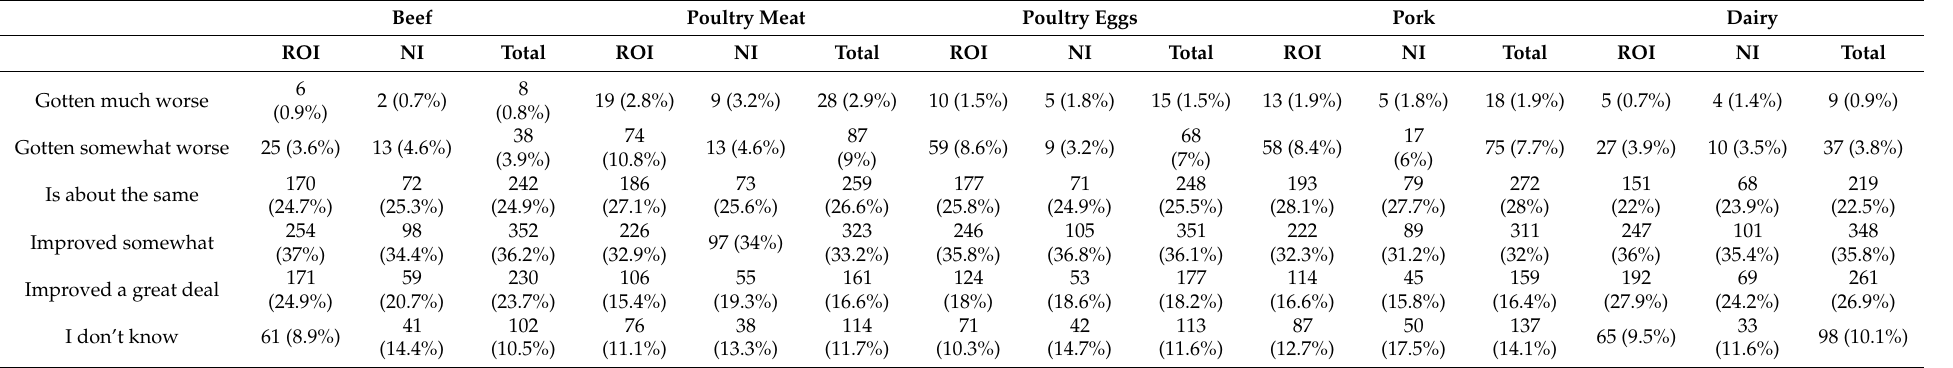
Table 3. Survey-based consumer perceptions ( n = 972) in the Republic of Ireland (ROI) and Northern Ireland (NI) of change in farm animal welfare over last ten years across five production sectors a